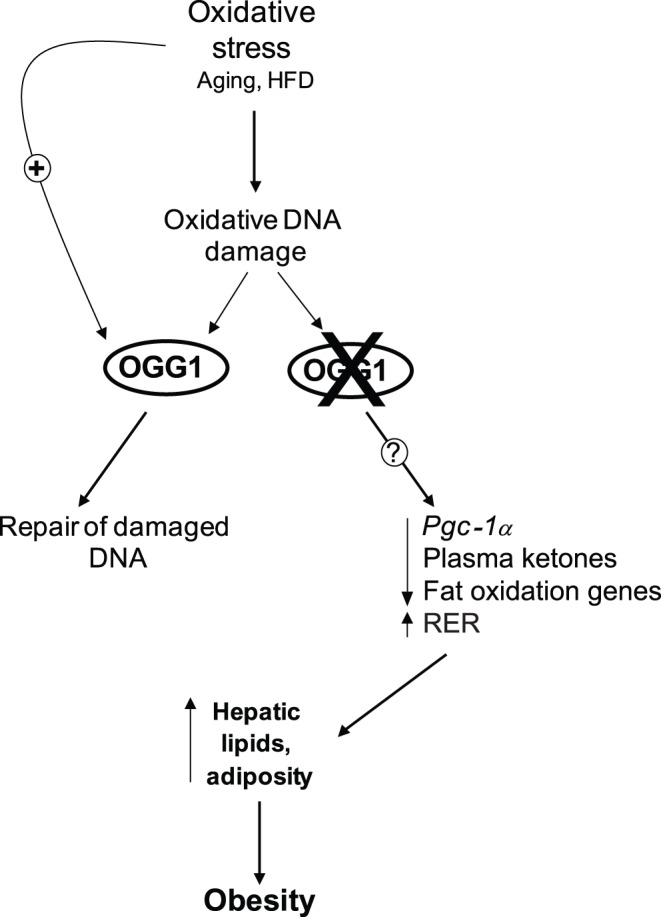
Proposed model for maintenance of metabolic health by OGG1.Oxidative stress, such as that induced by consumption of a HFD, damages cellular components, including DNA. Key BER glycosylases, such as Ogg1, are induced in response to this stress and help to restore genomic integrity. In contrast, in the absence of OGG1, through mechanisms that are as yet unclear, there is aberrant regulation of downstream factors such as Pgc-1α and fatty acid oxidation. These alterations lead to a potential fat-sparing phenotype in OGG1-deficient mice, resulting in accelerated development of hepatic steatosis and obesity upon HFD-feeding in Ogg1−/− mice.